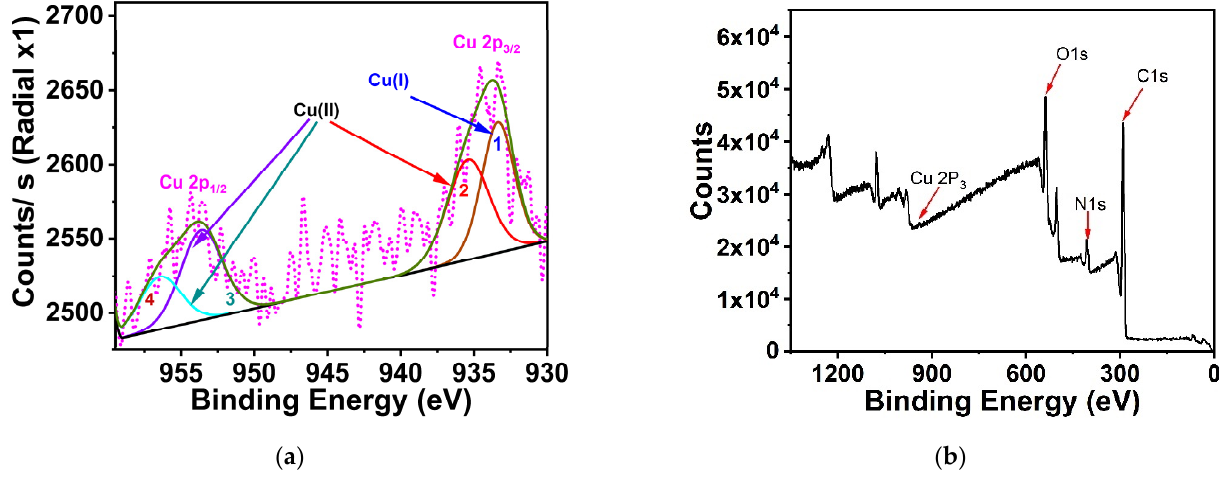
Figure 4. ( a ) XPS spectra of Cu2P for Pep-CuNCs; ( b ) The survey XPS spectrum of